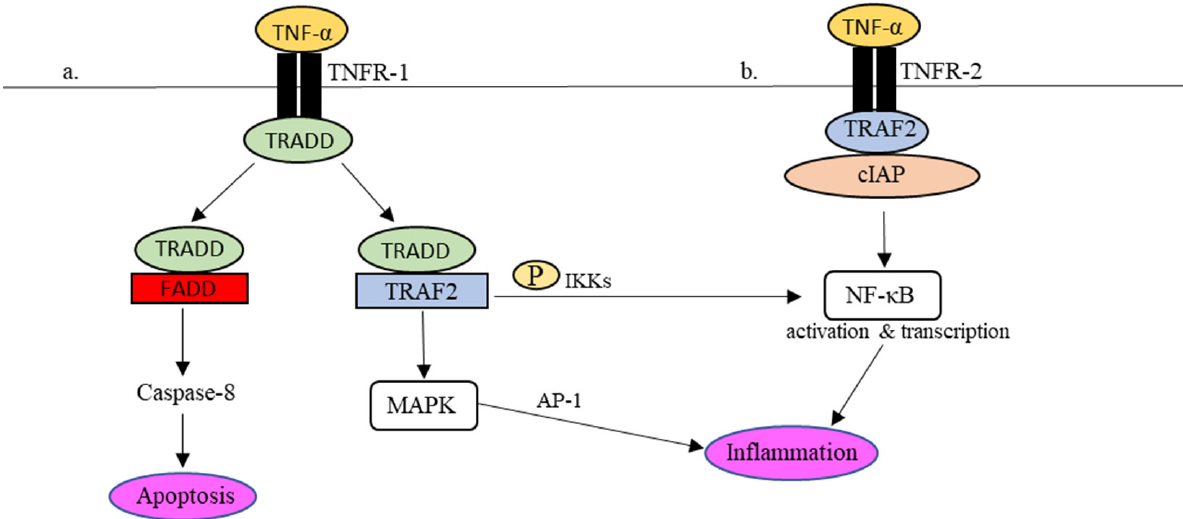
Figure 2. TNFR-1- and TNFR-2-mediated inflammatory responses in the TNF- α signaling pathway. ( a ) Upon TNFR-1 activation, TRADD is attracted to TNFR1 together with TRAF2 to phosphorylate NF- κβ and activate MAPK as well to regulate the expression of proinflammatory molecules. In addition, TRADD also binds to FADD, which leads to cell apoptosis via caspase-8. ( b ) In the event of TNFR-2 activation, the recruitment of TRAF2-cIAP complex to TNFR-2 activates the NF- κ B pathway, which results in the regulation of in fl ammation.